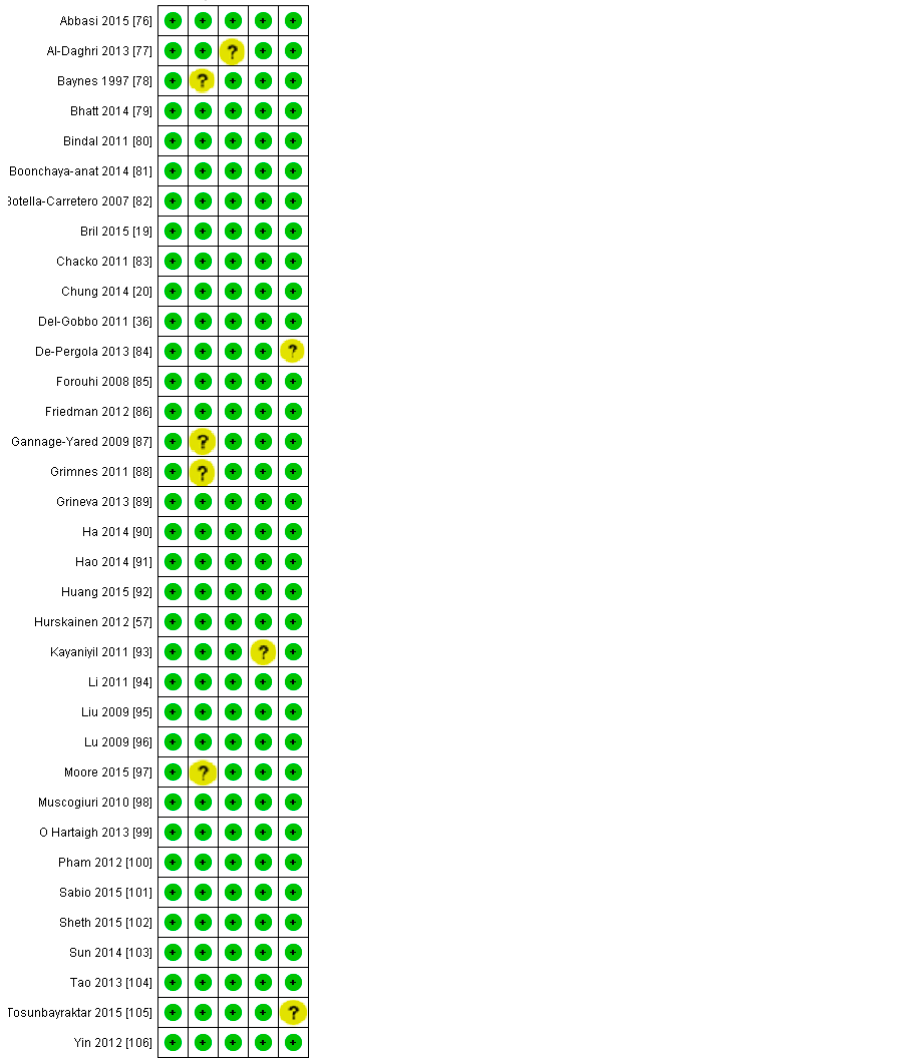
Figure 5. Risk of bias assessment for non-diabetic subject studies (plus sign shows low risk, minus sign shows high risk, and question mark shows unknown bias) [19,20,36,57,76–106].